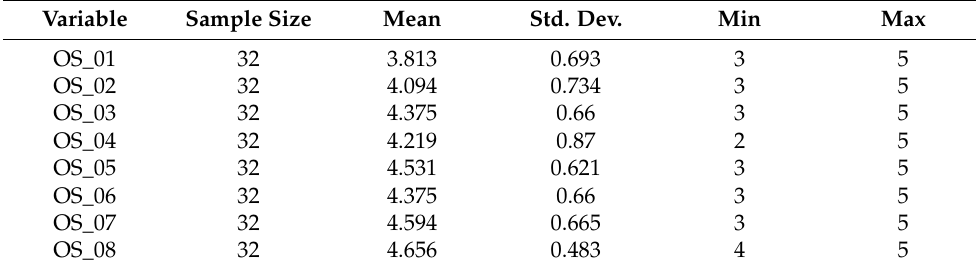
Table 7. Descriptive statistics by overall satisfaction’s items.